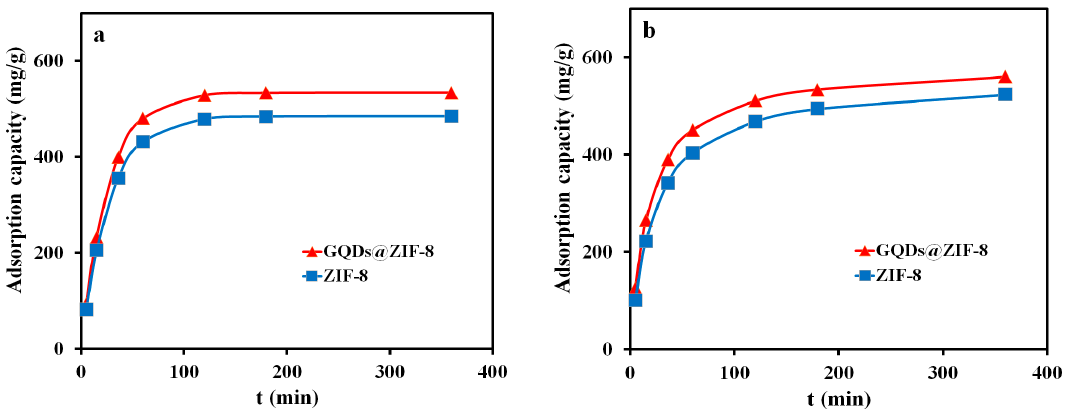
Figure 13. PFO ( a ), PSO ( b ) fitting curves of ZIF-8 and GQDs@ZIF-8 for toluene adsorption.